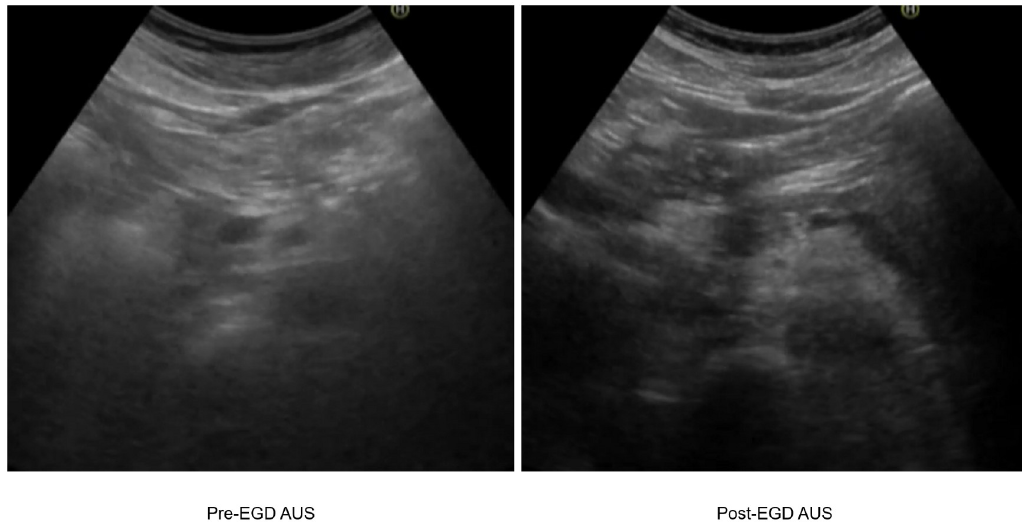
Fig 4. Image quality of pancreas body improved in some patients post-EGD